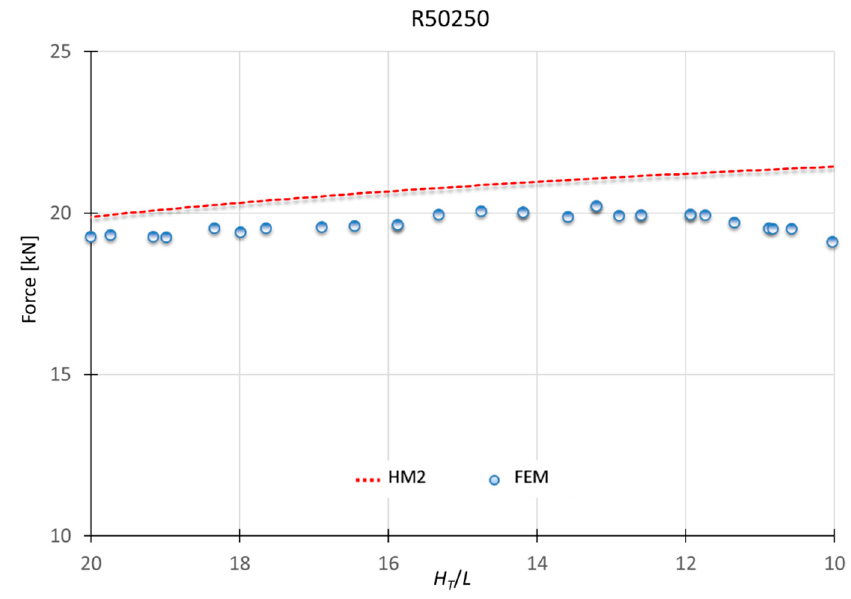
Figure 12. MUBT-FEM comparison for R50250, n = 0.23.